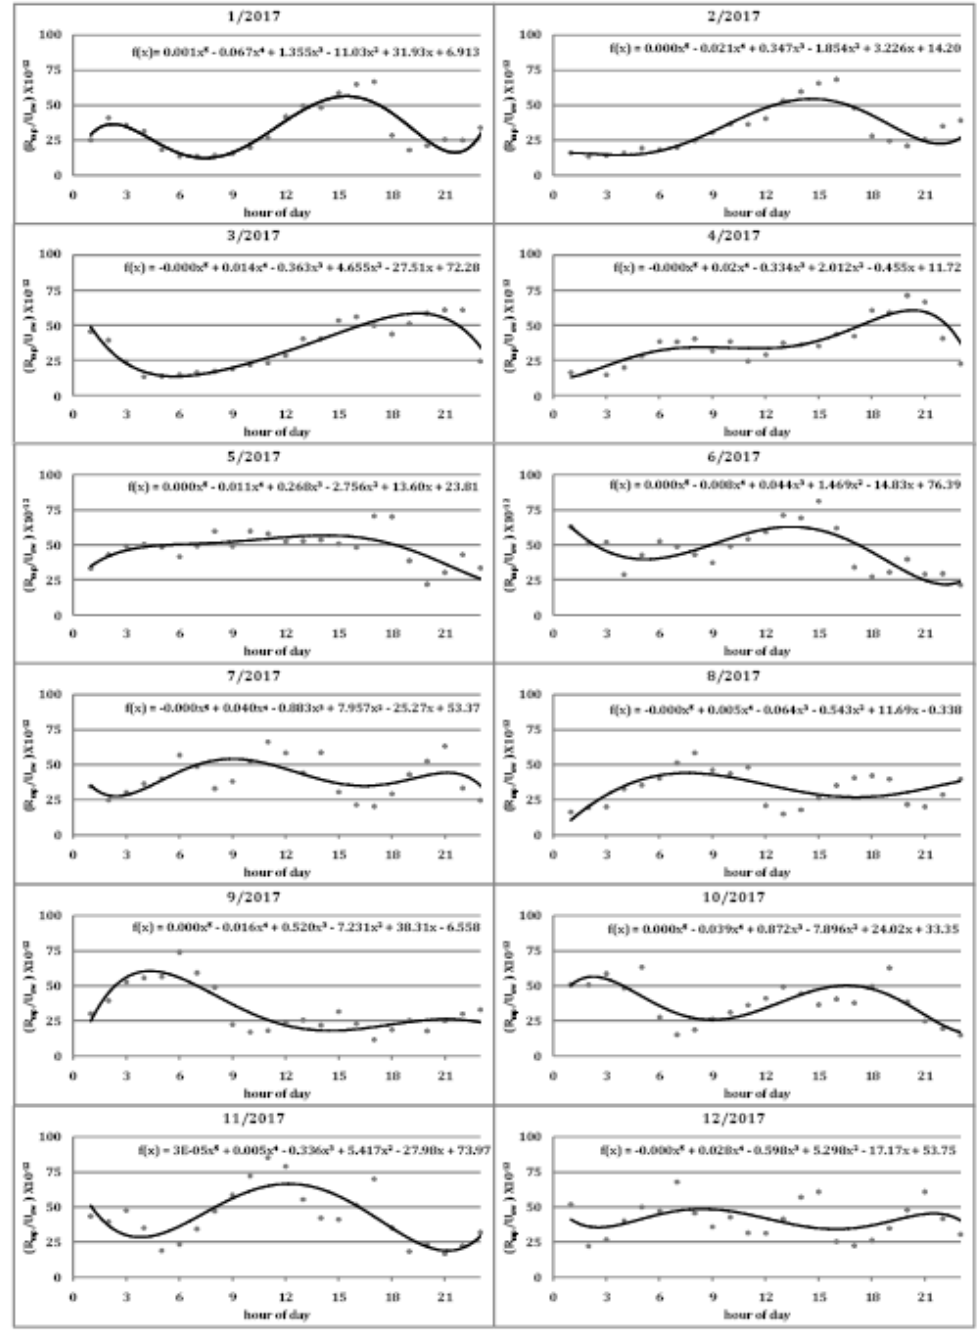
Fig. 7: Monthly median of (Rmp /Usw) for year